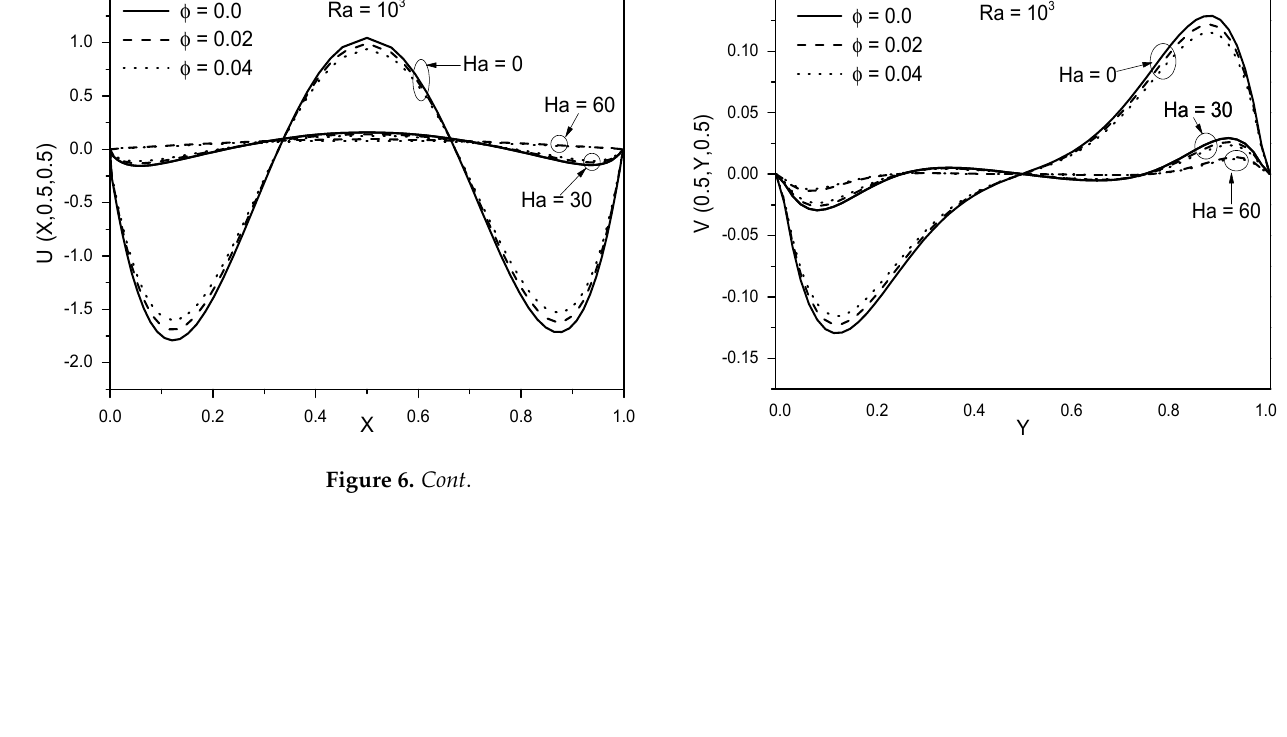
Figure 5. The variation of the temperature distribution along the X-axis for different Rayleigh numbers, Hartmann numbers, and the solid volume fractions at (d p = 10 nm). The impact of the Hartmann number and the solid volumetric fraction on the velocity profiles along the X-axis (left) and Y-axis (right) at three different values of (Ra) and (d p = 10 nm) was illustrated in Figure 6. These profiles are drawn at (Z = 0.5). With respect to the horizontal velocity profiles [U (X, 0.5, 0.5)].